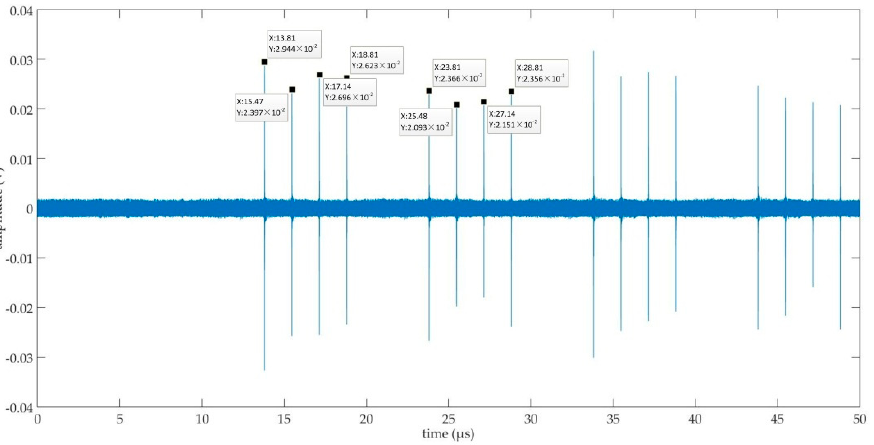
Figure 10. Output pulses of the TDS M-C arrangement.